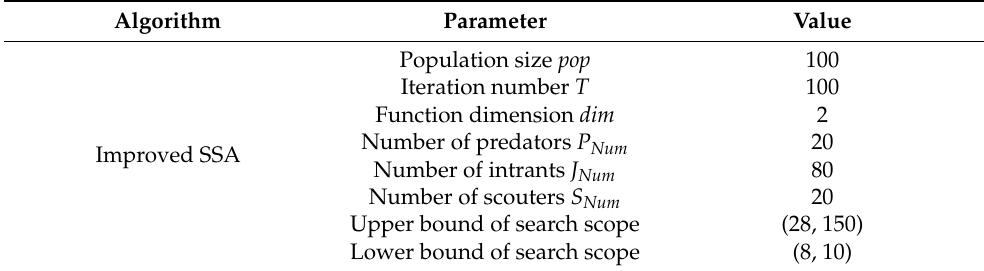
Table 2. Parameter setting of improved SSA.